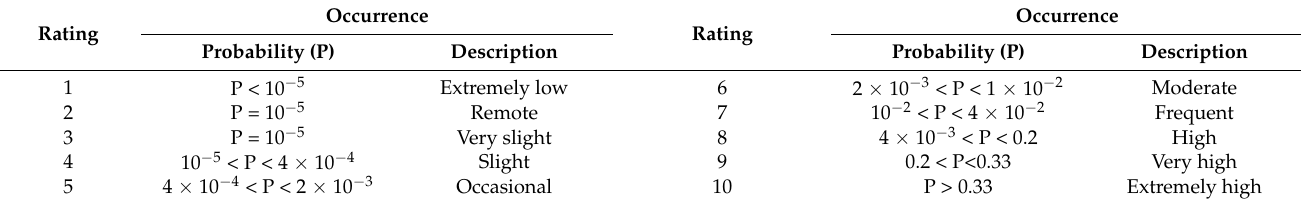
Table 11. The rating guidance of occurrence